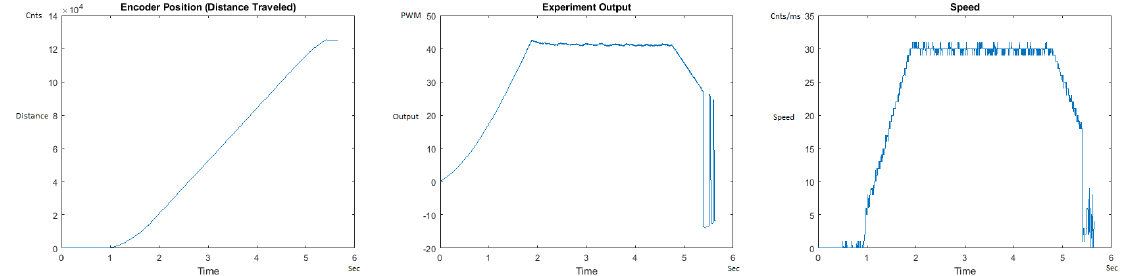
Figure 17. Encoder position, output and speed plots for PID++ UP operation— Vmax 30 cnts/ms, Adesired 0.015 cnts/ms 2 — 10